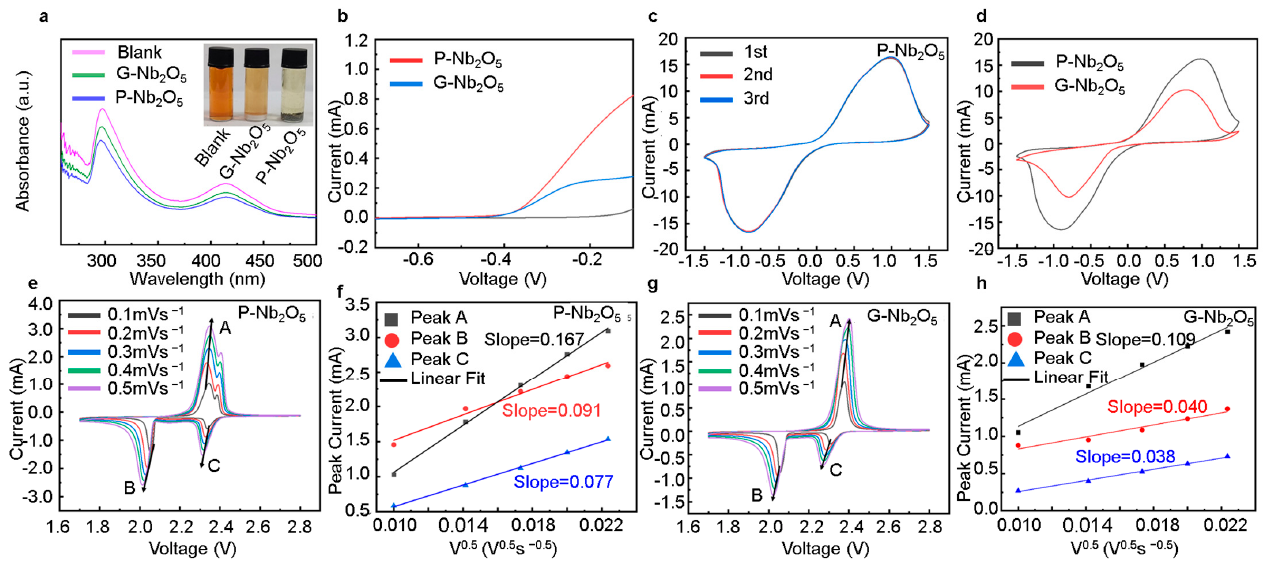
Figure 6. ( a ) UV-vis spectra and optical images of the P-Nb 2 O 5 and G-Nb 2 O 5 adsorbed LiPSs solutions. ( b ) Li 2 S oxidation LSV curve. ( c ) Symmetric battery cv curves for the P-Nb 2 O 5 . ( d ) Symmetric battery cv curves for the P-Nb 2 O 5 and G-Nb 2 O 5. ( e , g ) CV curves at different sweep speeds. ( f , h ) Linear regression line for peak A, peak B, and peak C.